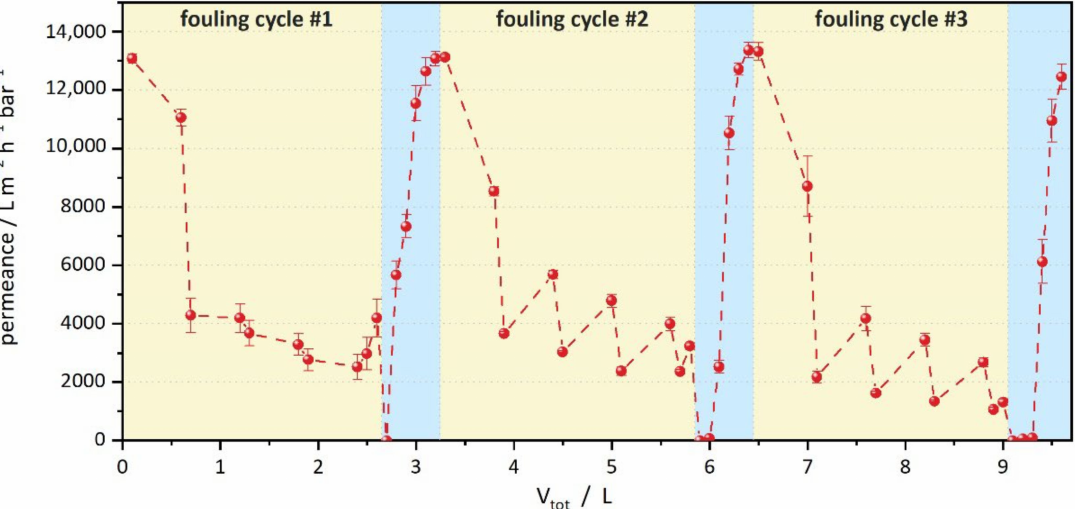
Figure 6. Reusability of lipolytic PVDF- g -EL within 3 consecutive fouling and self-cleaning cy- cles. Fouling cycles are highlighted with a yellow background, self-cleaning cycles (each 3 h) are highlighted with a blue background. PVDF-Ref was not used due to severe fouling after the first